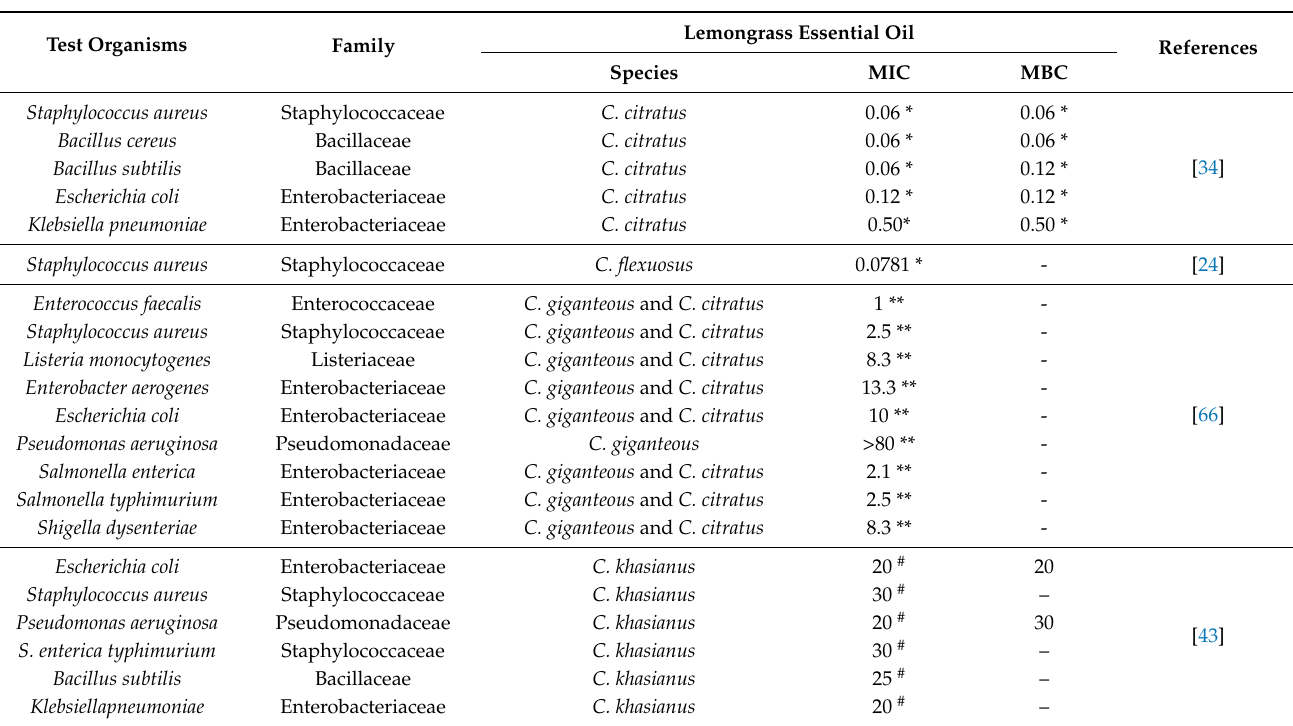
Table 2. The antibacterial potential of essential oil obtained from different lemongrass species against common pathogenic bacteria. MIC, minimum inhibitory concentration; MBC, minimum bactericidal